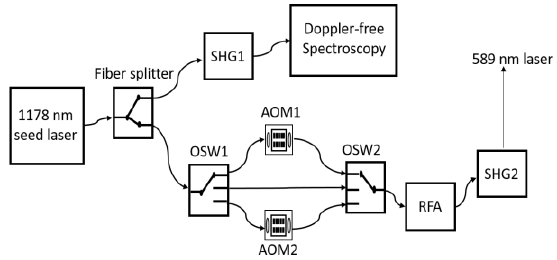
Fig. 1 Principle of fiber-coupled laser system.OSW1-3: fiber- coupled optical switcher; SHG1-2: second harmonic generation; RFA: Raman fiber amplifier; AOM1-2: acousto- optic modulator.